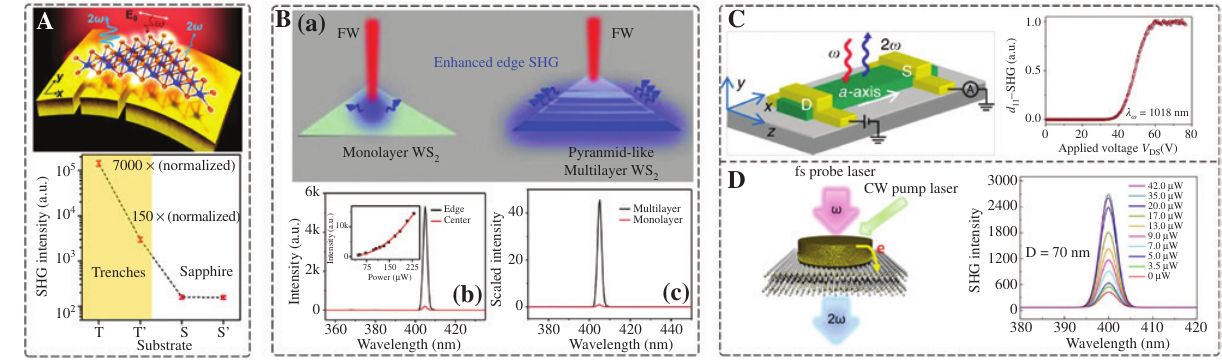
Figure 12: Enhancement and tunable SHG from 2DLMs. (A) Schematic of WSe -gold trench nanostructure (top) and SHG peak intensity of WSe on gold trenches and on sapphire (bottom) [222]. 2 2 The “7000” and “150” denote the normalized SHG enhancement factor under resonant and nonresonant excitation, respectively, where WSe on sapphire was used as a reference. (B) (a) Schematic of edge-enhanced SHG response in pyramid-shaped ML WS . (b) Spatially 2 2 resolved spectra collected from the edge and center of the P-ML WS . (Inset) Quadratic dependence of SHG intensity with pump power. (c) 2 SHG signals from P-ML (black) and monolayer (red) WS excited with a pulsed laser (810 nm) at a fixed pump power [219]. Reprinted with 2 permission from Refs. [219, 222]. Copyright 2018 American Chemical Society. (C) Schematic of a CdS nanobelt device with the source (S) and drain (D) electrodes (left) [225]. The long axis of the nanobelt ( x -axis) is determined to be CdS a -axis, which is perpendicular to the z -axis (or CdS c -axis). The fundamental wave at the frequency of ω is normally incident upon the belt and excites the second-harmonic wave at 2 ω , which is back scattered. (Right) Voltage dependence of d -SHG signal. (D) Schematic of PP measurement with a CW laser to manipulate the 11 SHG signal (left). (Right) Tunable SHG intensity of BL WSe -metal nanostructure (diameter 70 nm) with increasing pump power (CW, 532 2